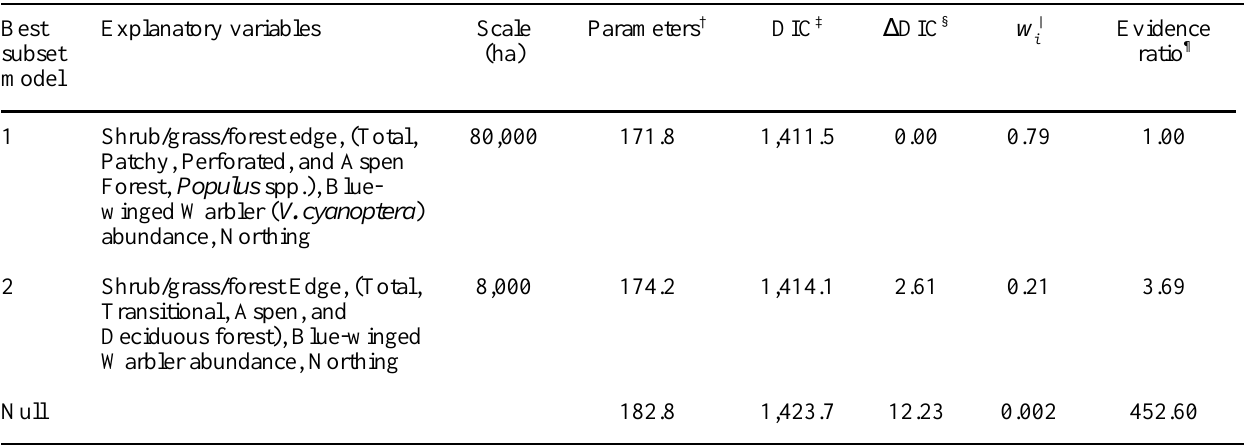
Table 2. Parameter estimates for the best subset of models fitted to 1981–2001 Breeding Bird Survey route counts for the Golden-winged Warbler ( Vermivora chrysoptera ) in the Prairie Hardwood Transition of the upper midwestern U.S. The Null model, included for comparison, is a model with observer and year random effects, but without environmental